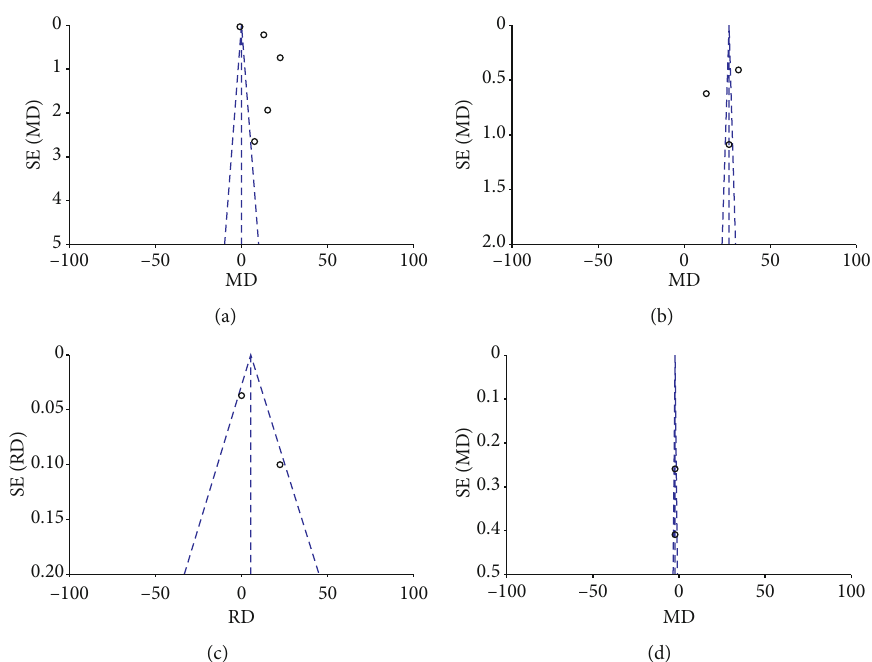
Figure 4: All of the funnel plots were symmetric, suggesting that there was no clear publishing bias: BI (a), Fugl-Meyer index (b), CSS (c), and NIHSS (d) of Publication bias.